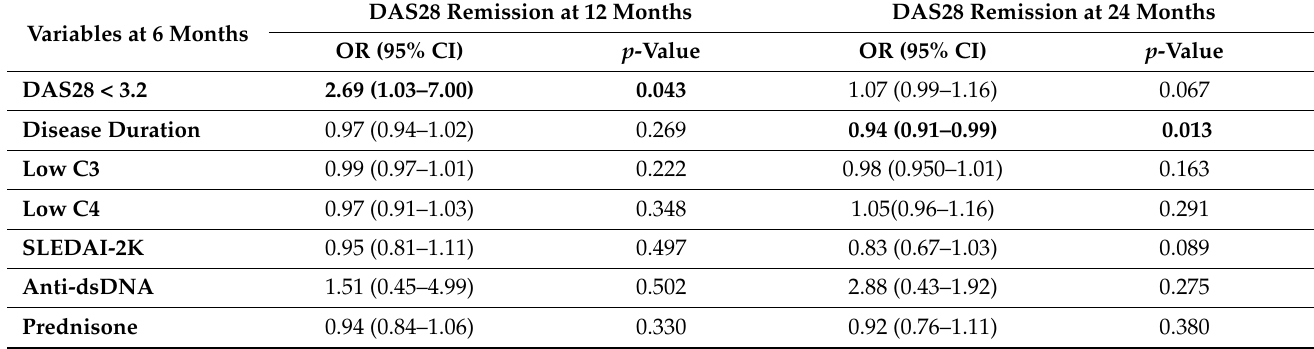
Table 5. Six-month predictors of long-term DAS28 remission in patients with partial response to